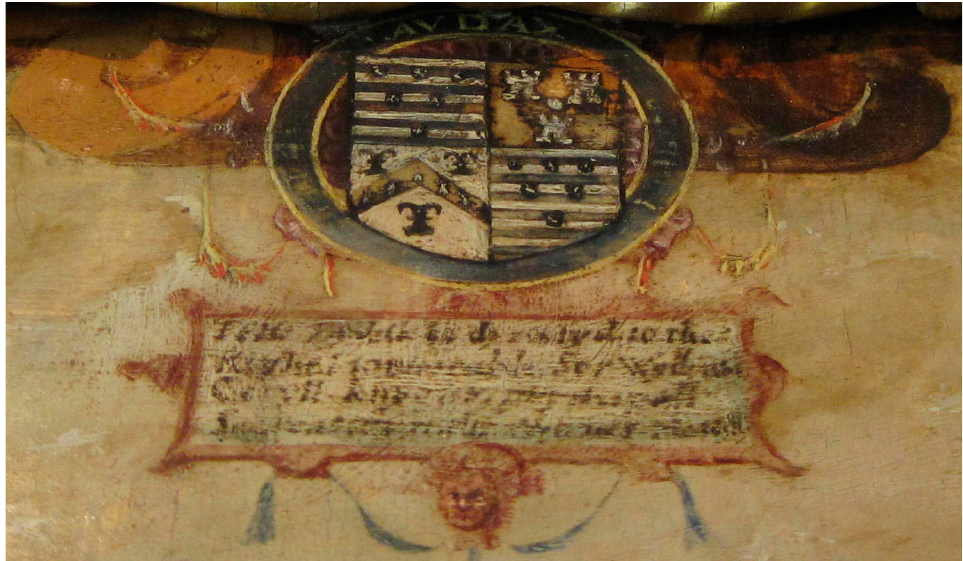
Figure 9. William Cecil’s coat of arms and the dedication on the painting, ‘A Riddle devoted to … Sir William Cecil’, c. 1565–70. Hatfield House, UK. Courtesy of the Marquess of Salisbury. Photo credit: Lyndan Warner.